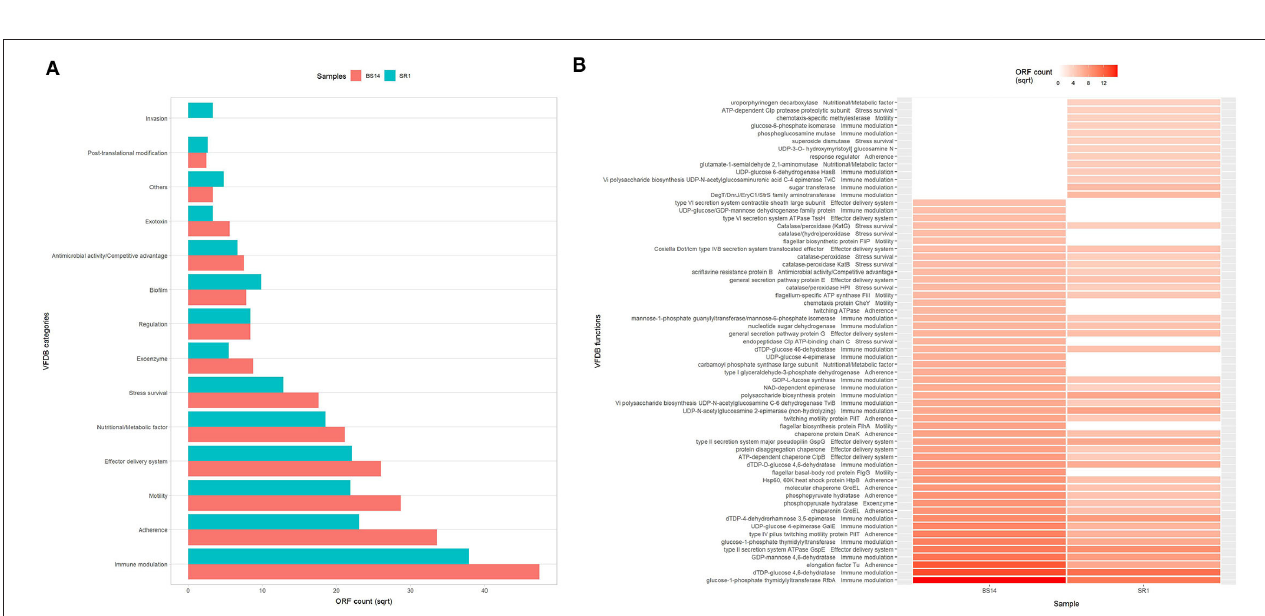
FIGURE 6 | (A) Distribution of virulent categories among the BS14 and SR1 samples from virulence factor database (VFDB) alignment and (B) heatmap showing the top 50 abundant virulent factors of BS14 and SR1 sample.